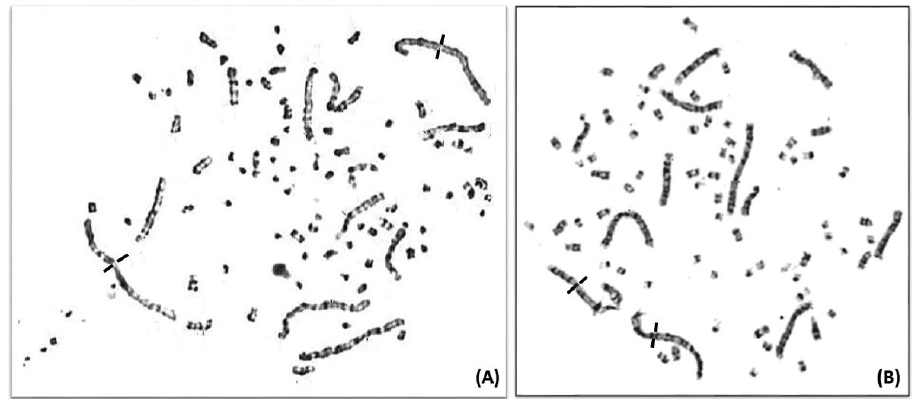
Figure 1. Prometaphase spreads following the GTG-banded chromosomes of A the Common quail Coturnix coturnix B Japanese quail Coturnix japonica (Black bars indicate the centromere positions of the chromosomes 1).